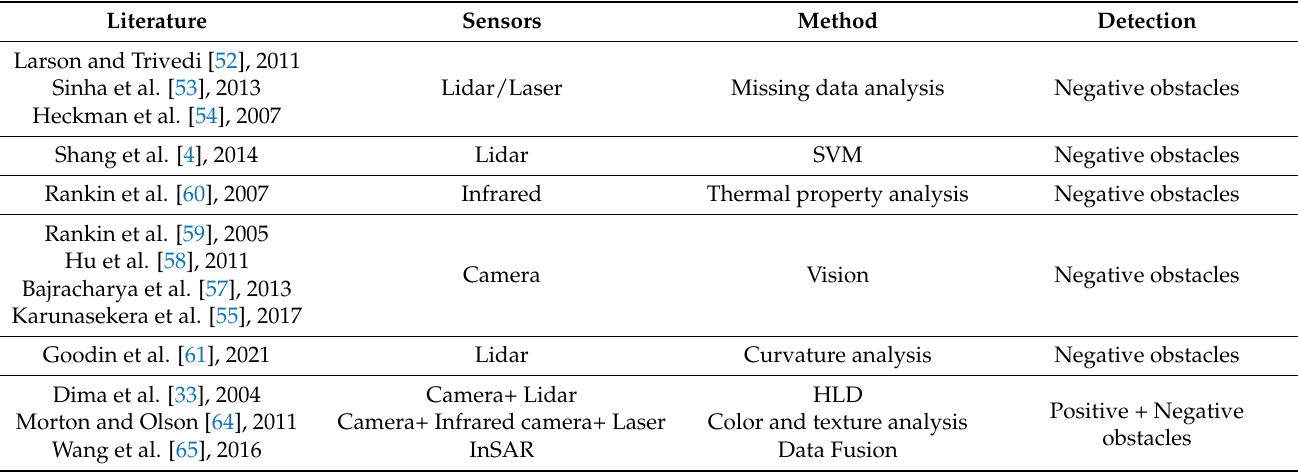
Table 4. The methods used for negative obstacle